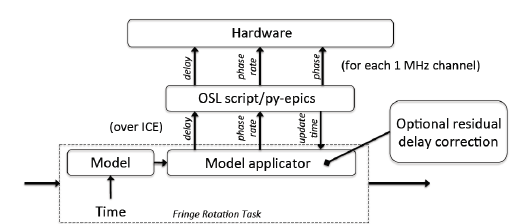
Figure 3. The fringe rotation task - an example of commissioning workaround enabled by the ingest pipeline. It allowed us to update the fringe rotation parameters in the hardware asynchronously and infrequently (via so called OSL script) and compensate for the residual error in software. This approach enabled early science faster and allowed us to investigate the timing across the